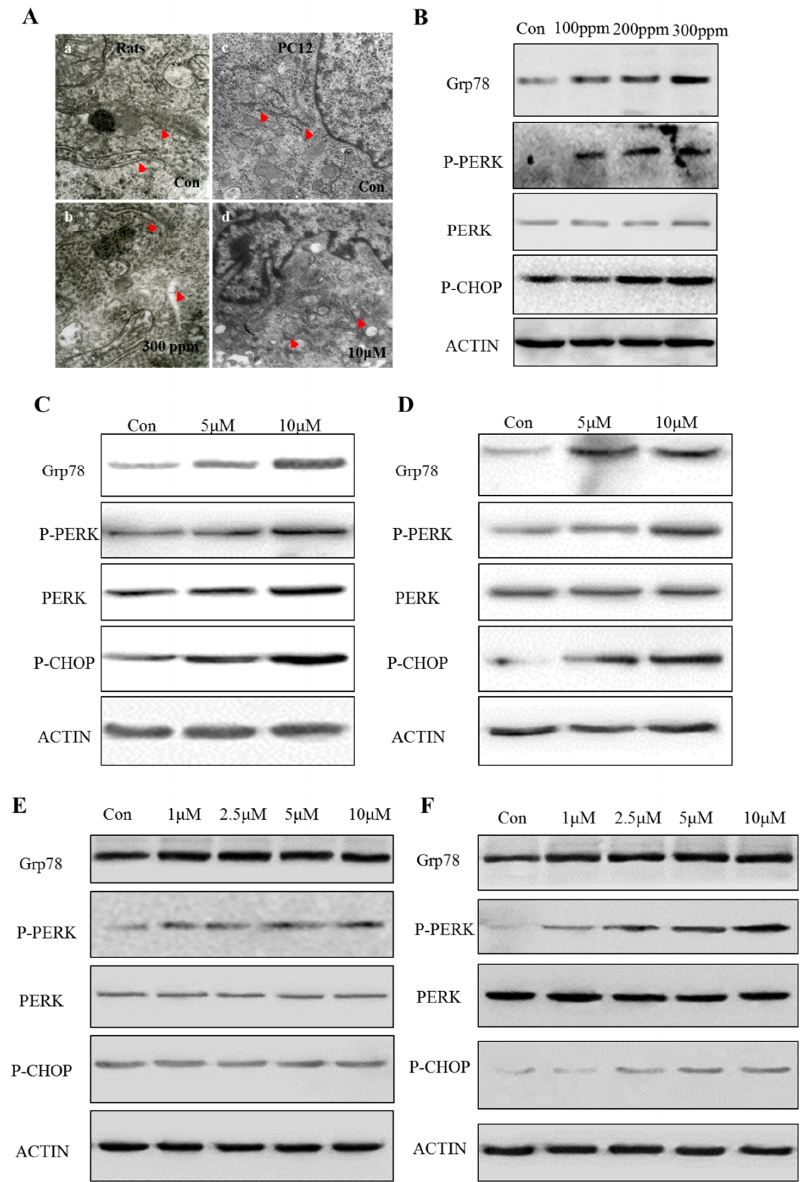
Figure 2. Pb exposure leads to ER stress. After Pb exposure, the changes in morphology of ER in rats and PC12 cells were observed under a high-resolution electron microscope ( Aa – Ad ). Western blotting was conducted to examine ER stress-related proteins and signaling pathways in SD rats ( B ). PC12 cells were treated for 12 h and 24 h with graded concentrations of Pb, and western blotting was conducted to examine ER stress-related proteins and signaling pathways in hippocampal neurons ( C , D ) and PC12 cells ( E , F